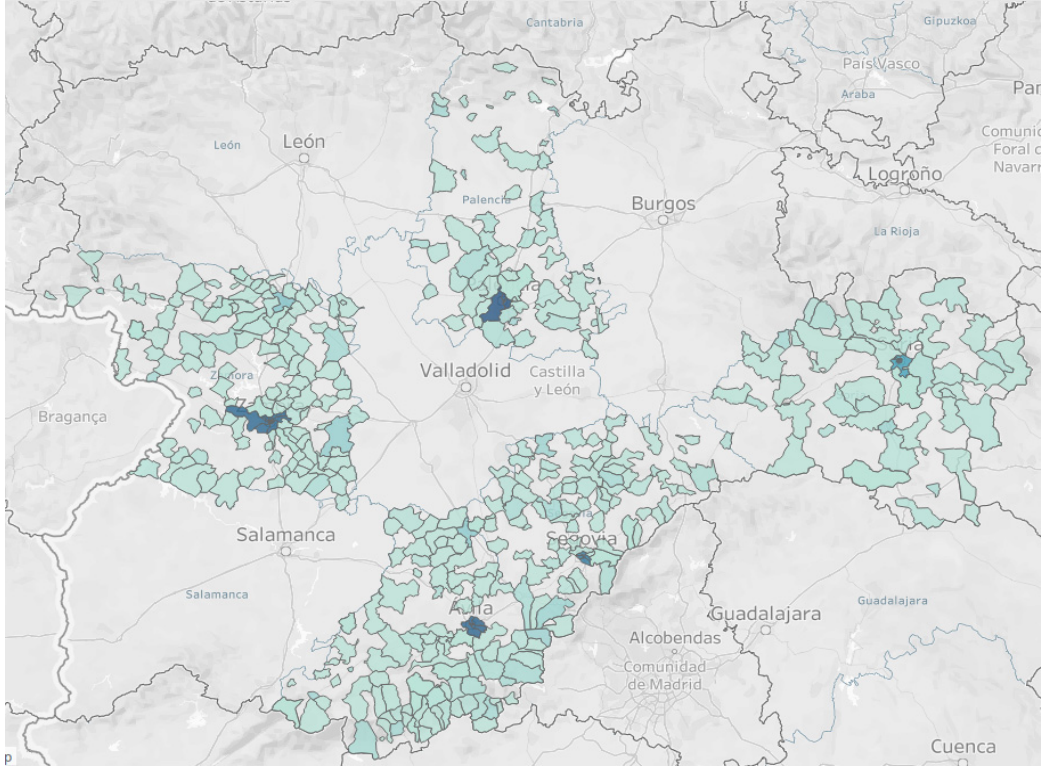
Figure 3. Access to cash in the final situation (including pharmacy network). Source: Own elaboration based on Table 1 and Tableau Desktop Proffesional Edition.